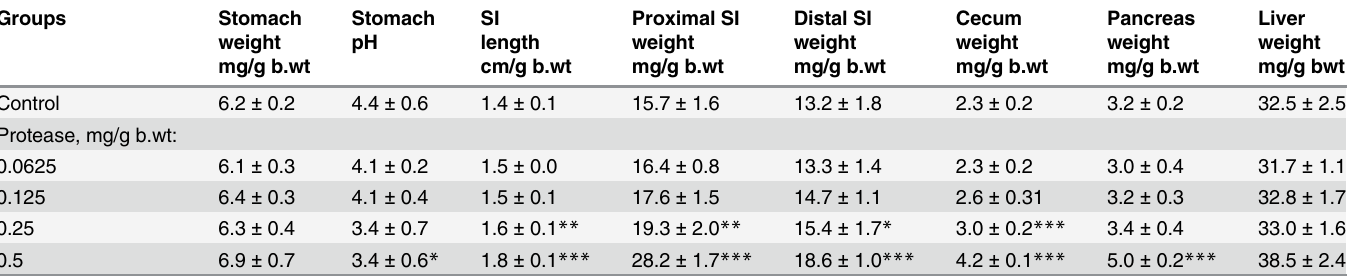
Table 5. Gut organ growth and stomach pH of 17 d-old rats after gavage feeding a microbial-derived protease in increasing doses, or water (control) during 14 – 16 days of age. Groups